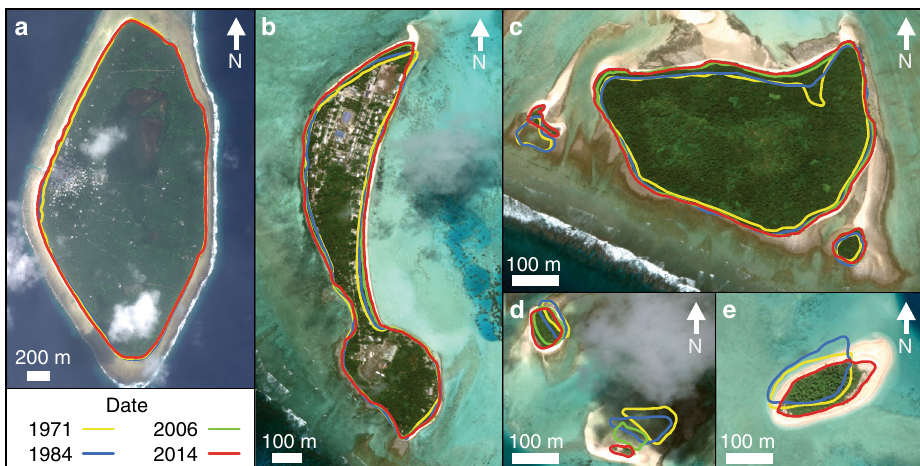
Fig. 3 Examples of island change and dynamics in Tuvalu from 1971 to 2014. a Nanumaga reef platform island (301 ha) increased in area 4.7 ha (1.6%) and remained stable on its reef platform. b Fangaia island (22.4 ha), Nukulaelae atoll, increased in area 3.1 ha (13.7%) and remained stable on reef rim. c Fenualango island (14.1 ha), Nukulaelae atoll rim, increased in area 2.3 ha (16%). Note smaller island on left Teafuafatu (0.29 ha), which reduced in area 0.15 ha (49%) and had signi fi cant lagoonward movement. d Two smaller reef islands on Nukulaelae reef rim. Tapuaelani island, (0.19 ha) top left, increased in area 0.21 ha (113%) and migrated lagoonward. Kalilaia island, (0.52 ha) bottom right, reduced in area 0.45ha (85%) migrating substantially lagoonward. e Teafuone island (1.37 ha) Nukufetau atoll, increased in area 0.04 ha (3%). Note lateral migration of island along reef platform. Yellow lines represent the 1971 shoreline, blue lines represent the 1984 shoreline, green lines represent the 2006 shoreline and red lines represent the 2014 shoreline. Images